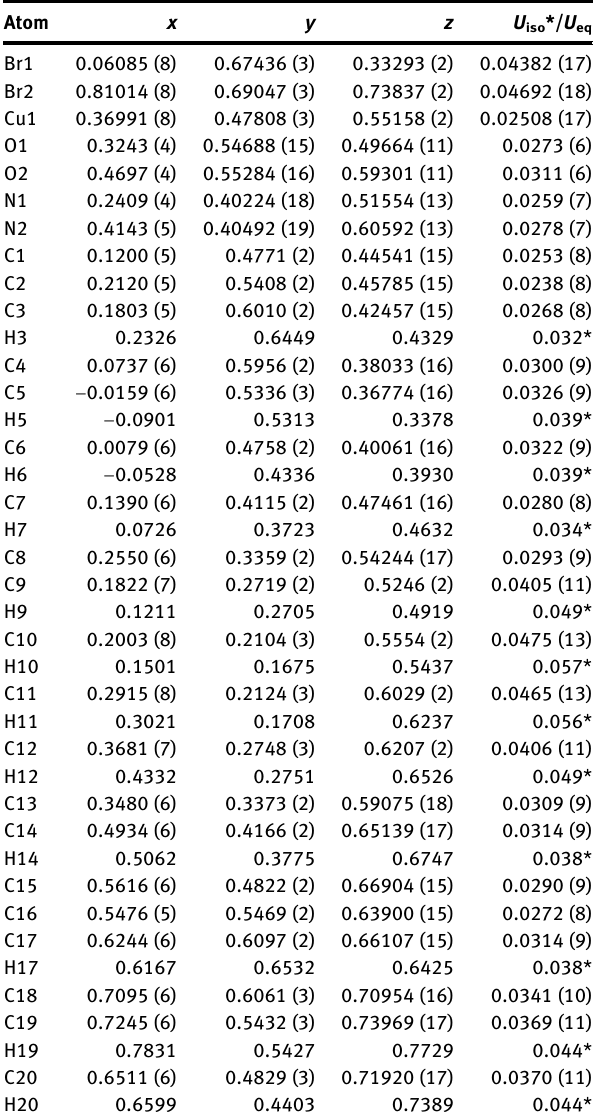
Table  : Fractional atomic coordinates and isotropic or equivalent isotropic displacement parameters (Å 